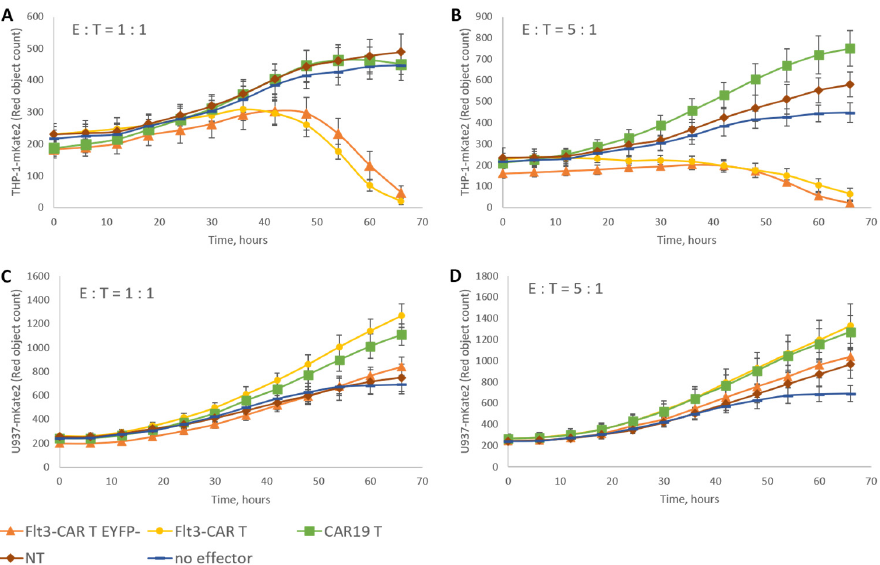
Figure 3. Specific Flt3-CAR T cell-mediated killing of target cells in vitro. Flt3-CAR T cells, Flt3- CAREYFP-T cells, CAR19 T cells, and non-transduced (NT) cells were co-incubated with THP-1- mKate2 cells at E:T = 1:1 ( A ) or 5:1 ( B ), or U937-mKate2 cells at E:T = 1:1 ( C ) or 5:1 ( D ). A color/shape legend for the lines and data points is given in the figure. ‘Red object counts’ acquired by IncuCyte ® reflect the viability of target (THP-1-mKate2 or U937-mKate2) cells. The data are represented as means ± SD.